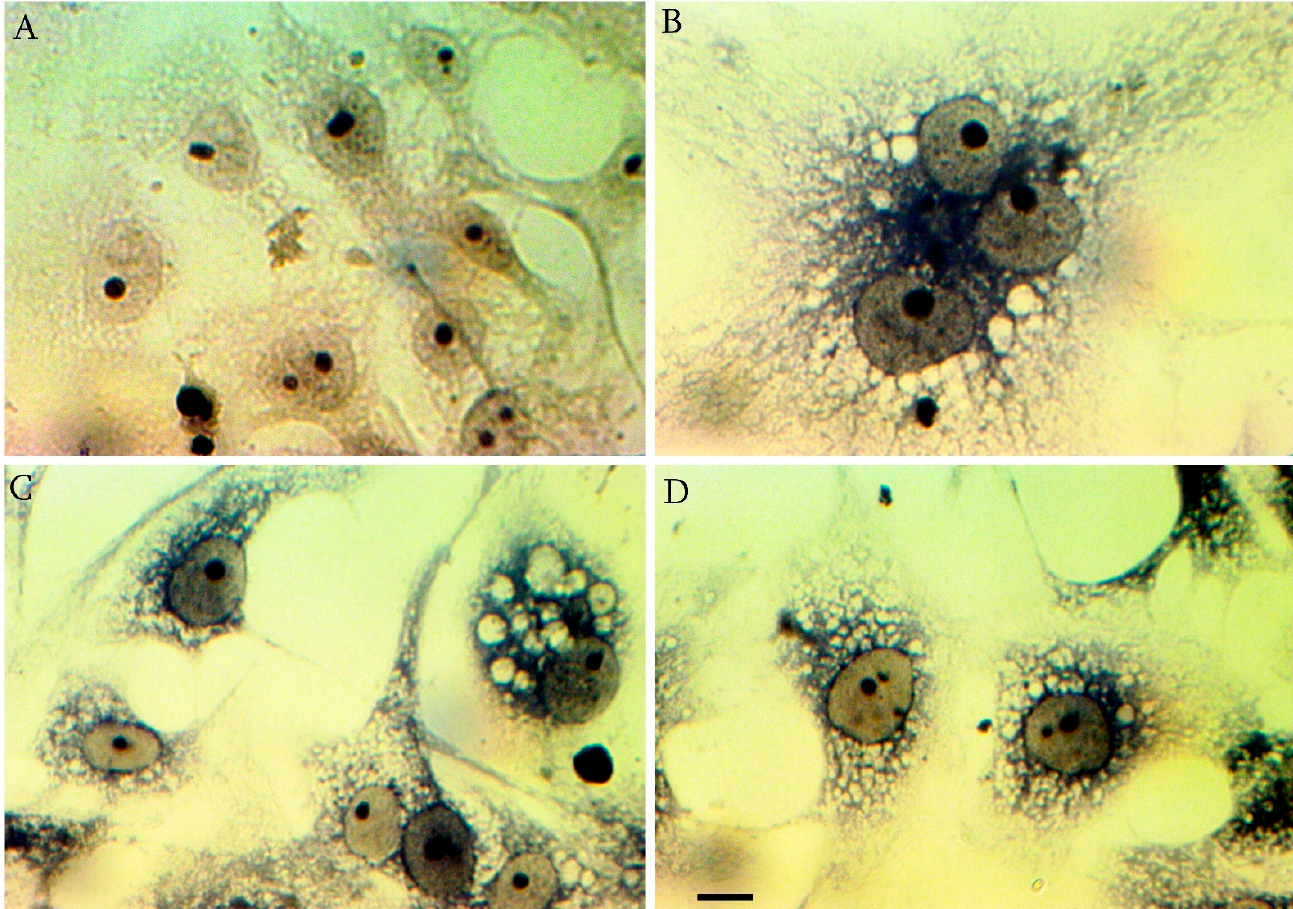
Figure 3. Cytopathic effect of SARS-CoV-2 on Iron hematoxylin stained Vero E6 cells (120 hpi). ( A ) Mock-infected control cells ( B ) The changes relate to the formation of synthicia ( C ) Massive vacuolization of infected cells ( D ) Vacuolization and disruption of the cell confluent (Figure 3D); scale bar for ( A – D ) 10 μ m.